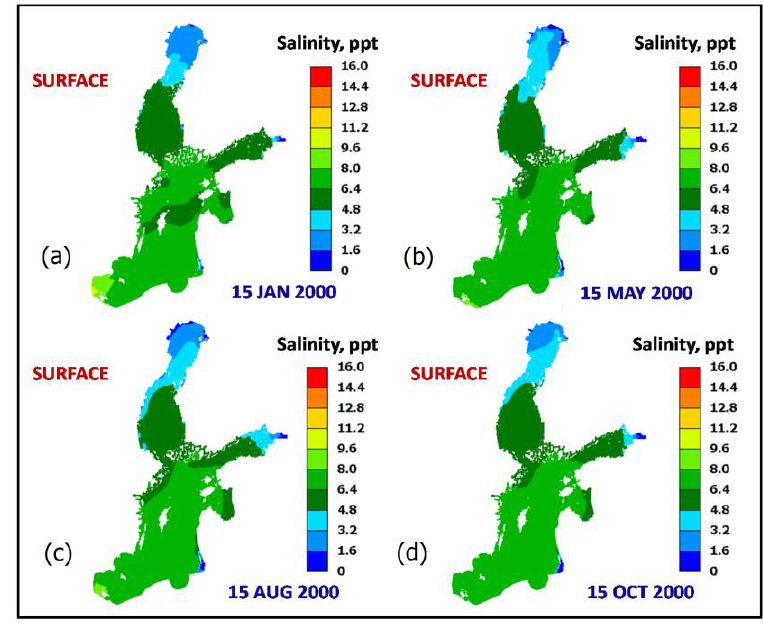
Figure 15. Seasonal plots of surface salinity in the Baltic Sea for the year 2000. ( a ) Winter; ( b ) Spring; ( c ) Summer; ( d ) Autumn.